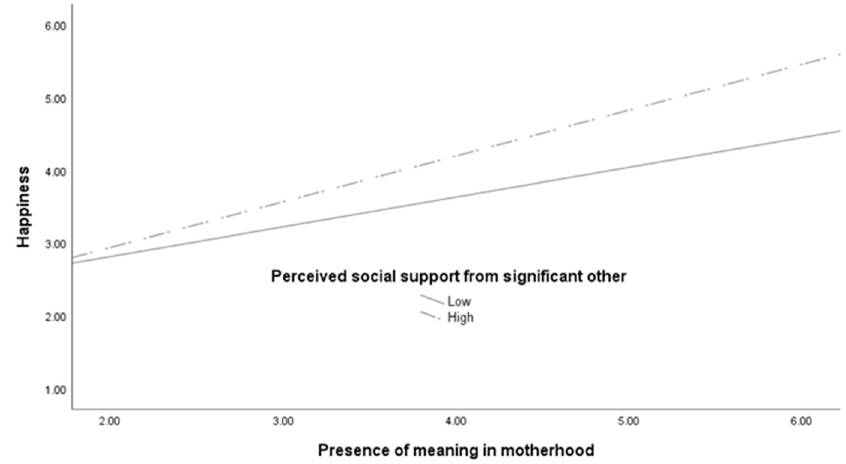
Figure 2. Association of older mothers’ presence of meaning in motherhood and happiness as a function of their perceived social support from significant other.